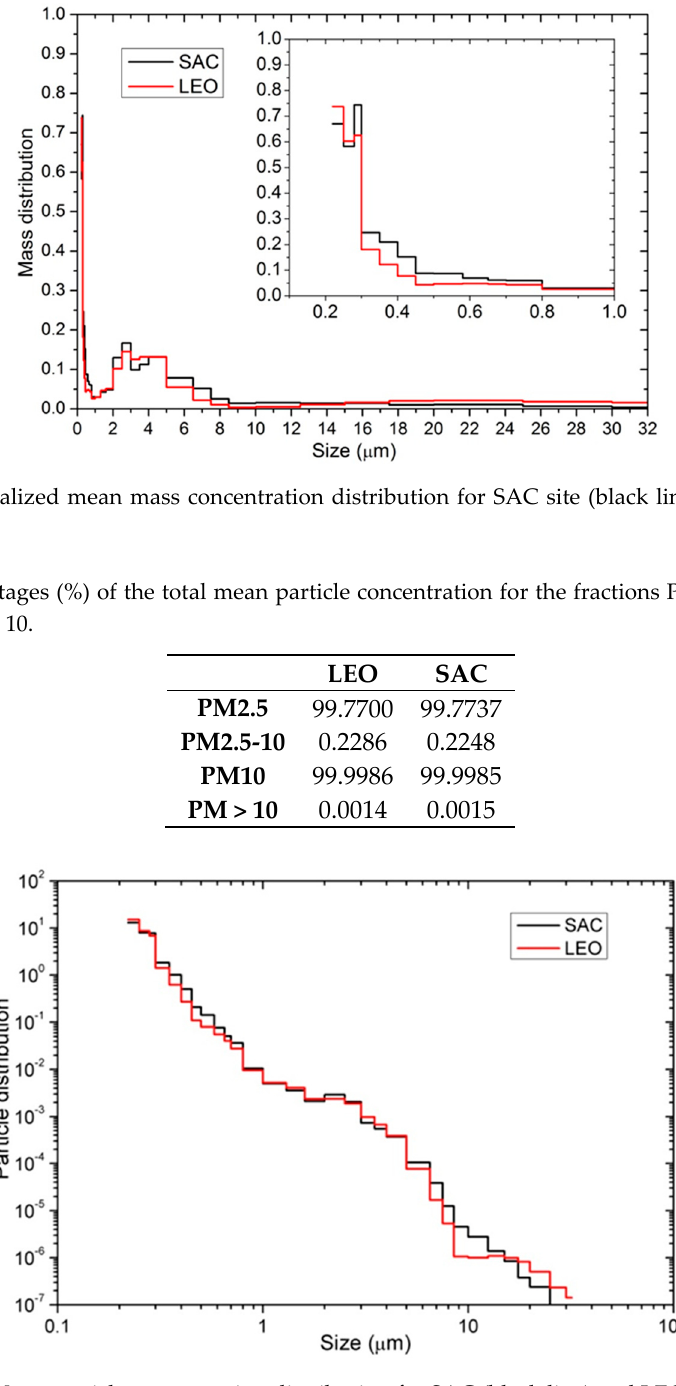
Figure 3. Mean particle concentration distribution for SAC (black line) and LEO (red